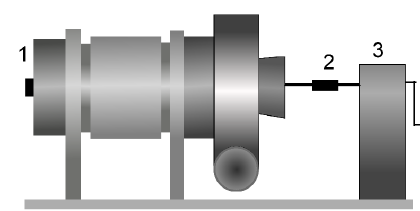
Figure 7: Test rig for the displacement sensor calibration 1- dis- placement sensor, 2- force gauge, 3- load screw.